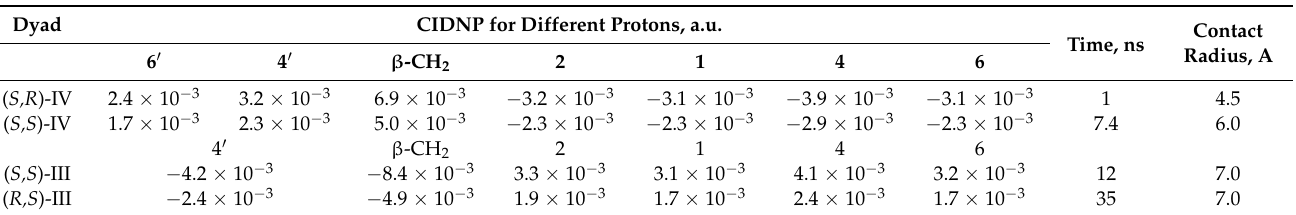
Table 9. Calculated CIDNP effects for dyads III, IV within S-T 0 approximation using times analogs from MD simulations. CIDNP for Different Protons,